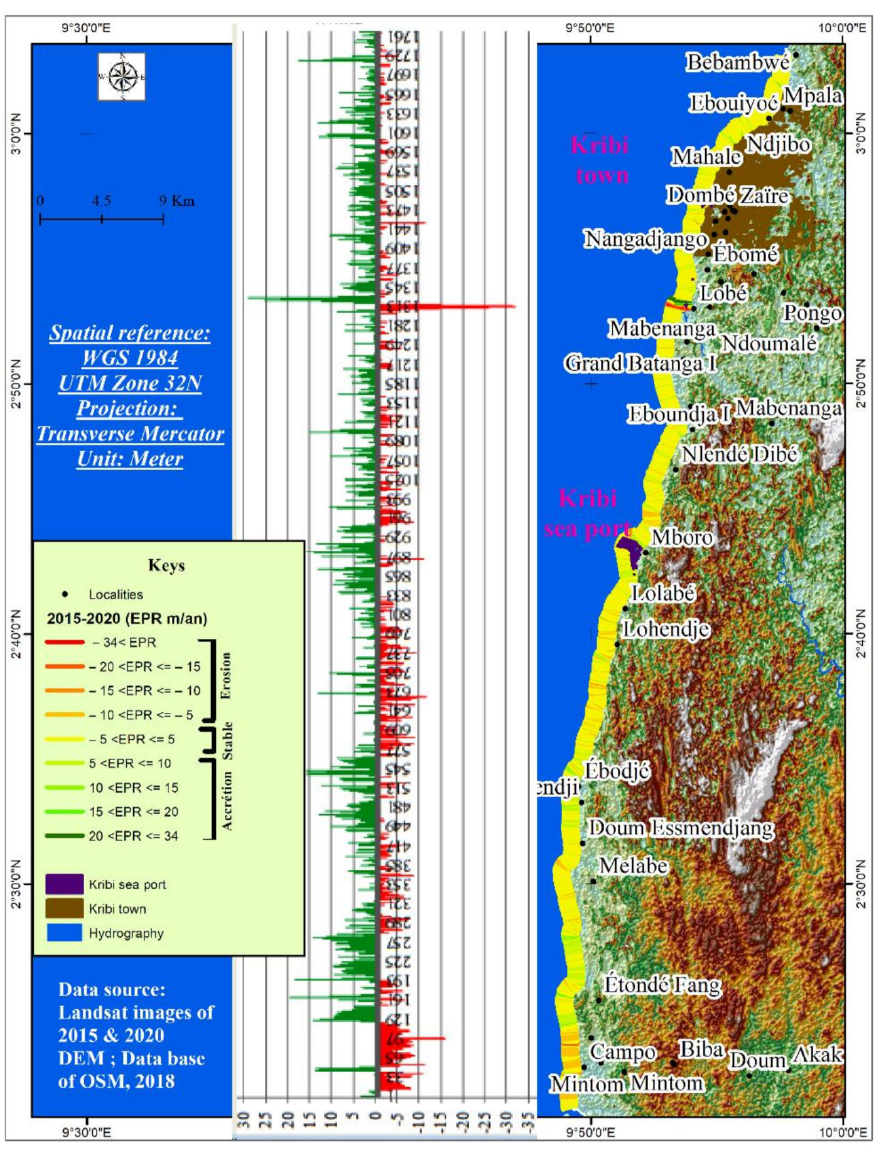
Figure 16. Coastal erosion on the Kribi coast with respect to speed (meters per year) between 2015 and 2020 obtained with DSAS, from linear data extracted from Landsat